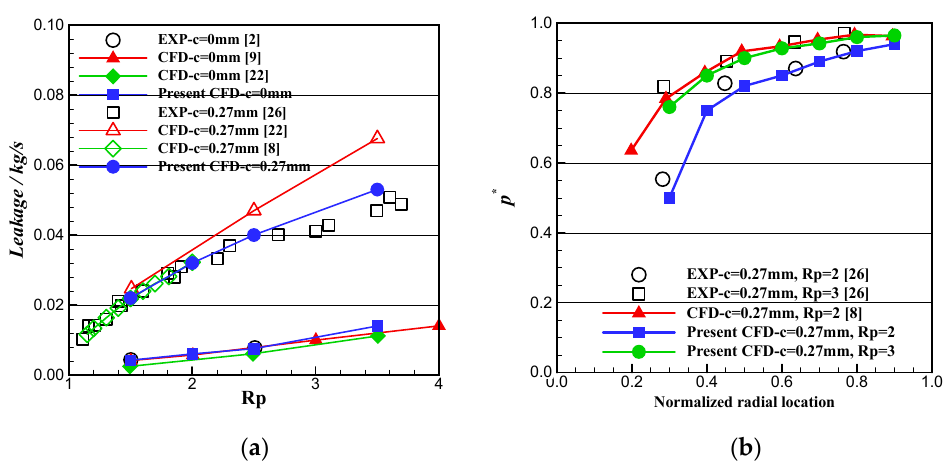
Figure 7. Comparisons of the present results with previously published data: ( a ) leakage flow; ( b ) pressure variation along radial backing plate.